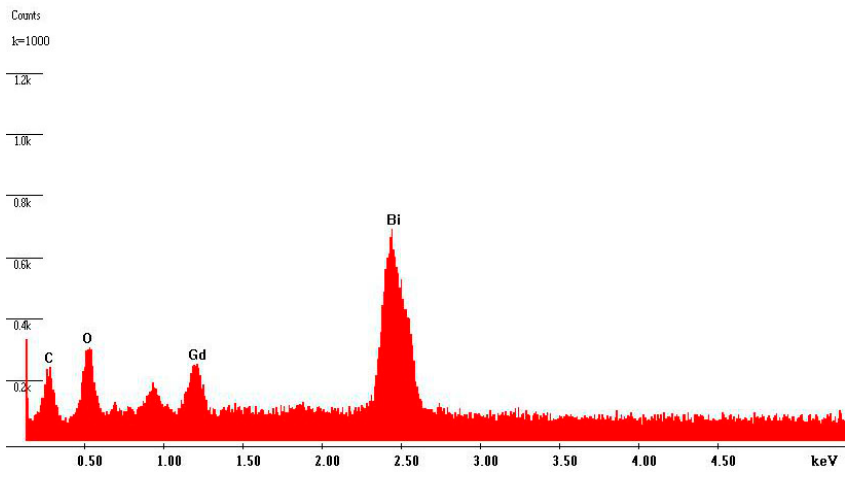
Figure 6. EDS spectrum of BiGdO 3 .